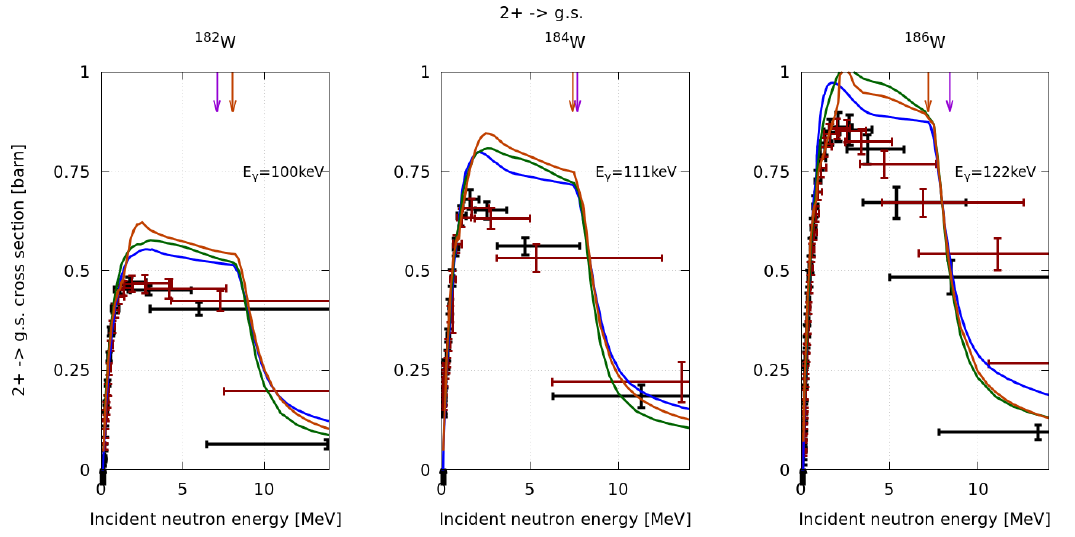
Figure 1. (n, n’ γ ) cross sections measured with GRAPhEME for the isotopes 182 W (left), 184 W (center), 186 W (right), for the first excited state (2 + ) to the ground state gsb transition. The data from isotopic targets are represented with black crosses, the data from the nat W target in red (corrected for 183 W(n,2n γ ) contamination for 182 W). It is compared to TALYS-1.73 (blue line), EMPIRE (orange line) and CoH3 (green line) calculations. The excitation energy of the decaying level is marked with the black up-pointing arrow on the bottom axis. The neutron separation energy S and proton separation energy S are n p marked with the orange and purple down-pointing arrows at the top,